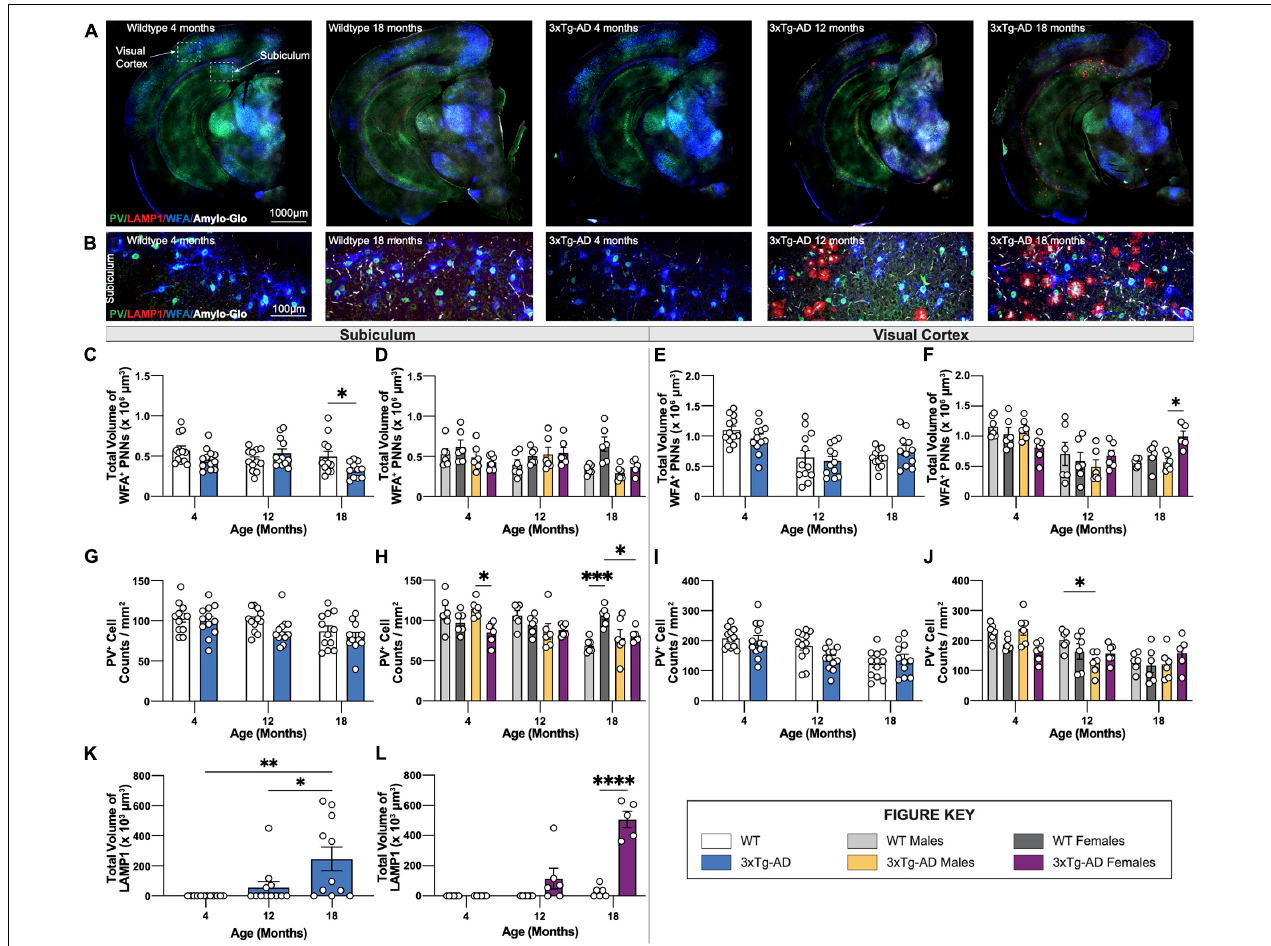
FIGURE 8 | PNN and LAMP1. Perineuronal nets (PNNs) and parvalbumin (PV) interneurons were assessed with immunostaining using WFA and PV antibody, while lysosomes were assessed with immunostaining using LAMP1 antibody. (A) Representative images of WT (4-, 18-month) and 3xTg-AD mice (4-, 12-, 18-month) stained with PV/LAMP1/WFA/Amylo-Glo. (B) Representative images of WFA + PNNs surrounding PV + neurons around LAMP1 + lysosomes in subiculum hippocampal regions of WT and 3xTg-AD mice across respective timepoints. (C–F) Age-related change in total volume of WFA + PNNs in 3xTg-AD mice. (G–J) Immunostaining for PV + neurons demonstrate age-related changes in the density of PV + neurons in both WT and 3xTg-AD mice, and differences between genotypes in subiculum and cortical regions. n = 5–6 mice per genotype/age/sex. (K,L) LAMP1 immunostaining reveals age- and sex-associated increases in the total volume of LAMP1 + lysosomes in the subiculum brain region of 3xTg-AD mice. n = 6 mice per genotype/age/sex. Data are represented as mean ± SEM. ∗ p ≤ 0.05, ∗∗ p ≤ 0.01, ∗∗∗ p ≤ 0.001, ∗∗∗∗ p ≤